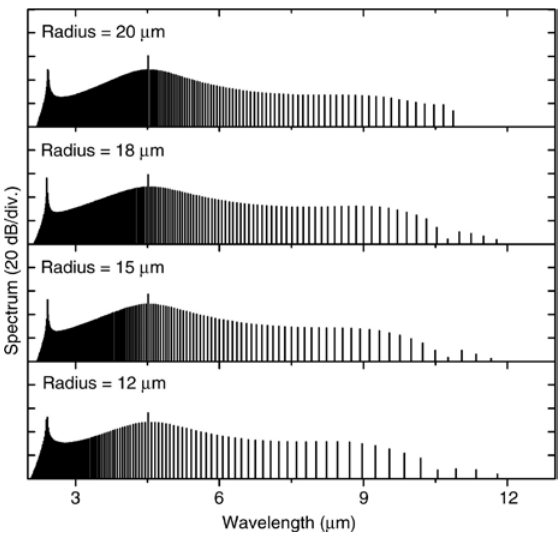
Figure 7: Frequency comb generation at different bending radii with the same pump